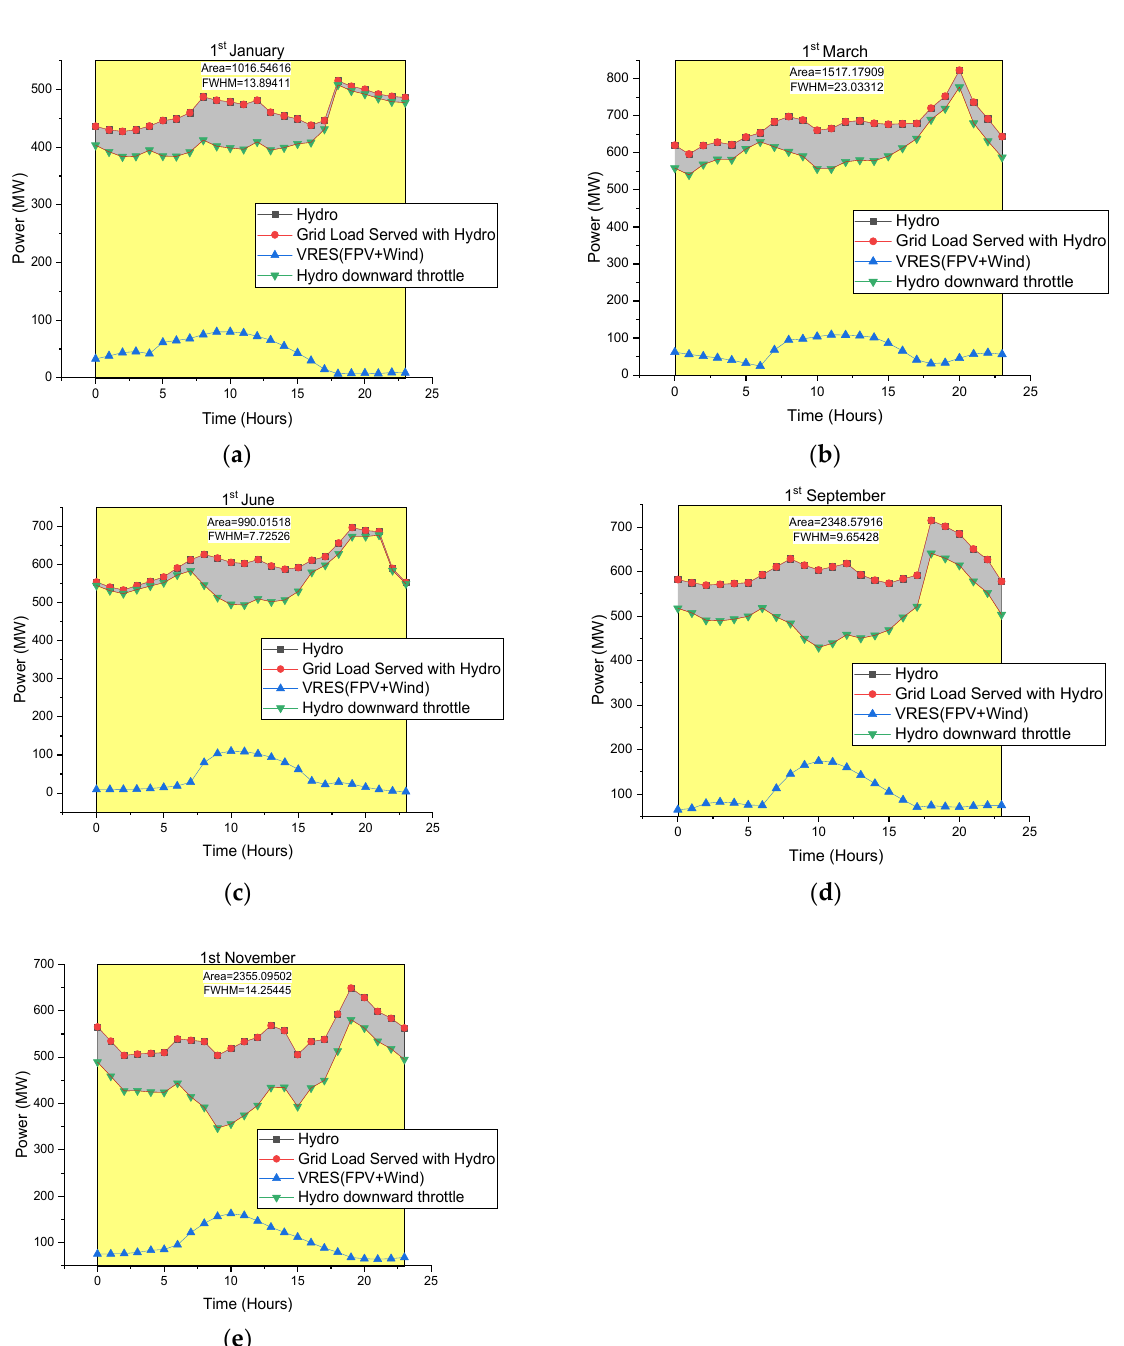
29 of 41 Figure 18. Graphic showing a hybrid energy system schematic in Homerpro. Optimal Daily Dispatch and Reservoir Water Saving The optimal dispatch of the hybrid energy system at KGU involved the prioritizing of FPV and wind to serve the load and the excess met by hydropower. From Figure 19a below, 1.15 GWh of VRES generation dispatch translated into a reservoir water-saving potential of 9.5% (equivalent to 1.02 GWh of generation) on 1 January. According to Figure 19b, a water-saving potential of 9.7% (equivalent to 1.52 GWh of generation) was realized with a dispatch of 1.67 GWh of VRES on 1 March. Figure 19c shows a water-saving potential of 7.2% with a dispatch of 1.14 GWh of VRES on 1 June. Both 1 September and 1 November yielded better water-saving potentials of 16.8% and 18.7% with VRES dispatch of 2.52 GWh and 2.35 GWh, respectively (Figure 19d,e). Therefore, using the customized Homer-Matlab dispatch code, 4.93 TWh of annual energy consumption was served, translating into 28 percent more demand served when compared to other default dispatch strategies embedded in Homerpro. This load was met by 166 GWh/year of wind, 175 GWh/year of floating photovoltaics, in the presence of 4.59 TWh of hydrogeneration (five out of six 140 MW hydrogenator units with a 10% reserve operating margin per unit) and